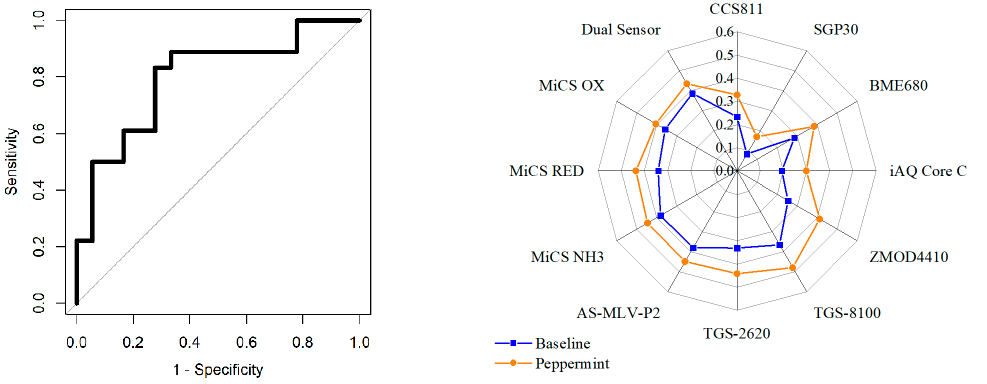
Figure 13. Baseline vs. peppermint exhaled breath samples; ( left ) ROC curve; ( right ) Peppermint breath test radar plot of normalised features.